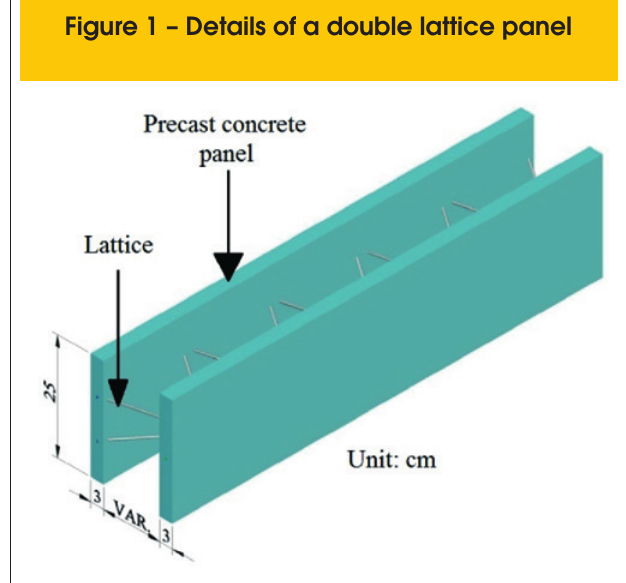
Figure 1 – Details of a double lattice